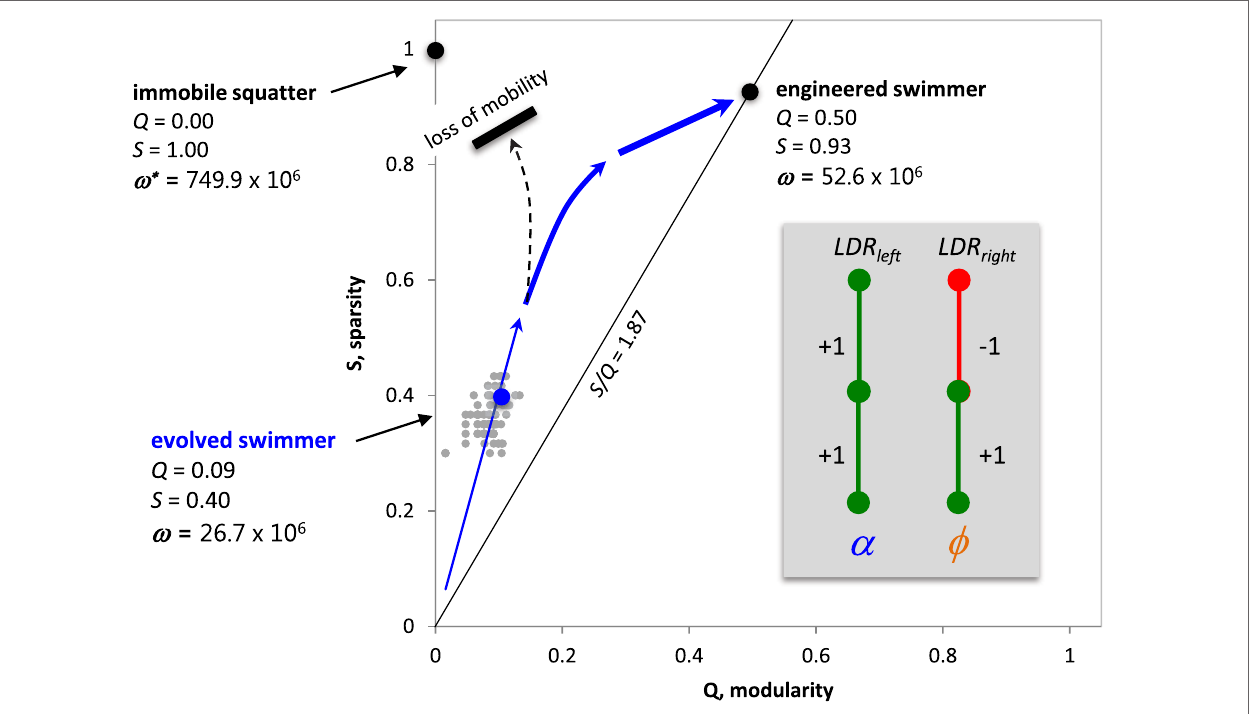
FigUre 12 | Predicted Q – S fitness landscape for Tadros under selection for enhanced phototaxis in a world with a single light source . While the immobile squatter has the highest light-gathering possible, the evolutionary path to that spot is blocked because of the need for mobility in the behavioral task of phototaxis. Hence, we predict that the population, given more time, will follow a path (blue arrows) toward the higher fitness of the engineered swimmer, evolving an ANN with high S whole , intermediate Q , and no recurrence. For the experimental data (gray points), over 10 generations S whole and Q were positively and significantly correlated ( r = 0.407, p < 0.001). Inset: engineered ANN from Figure 1